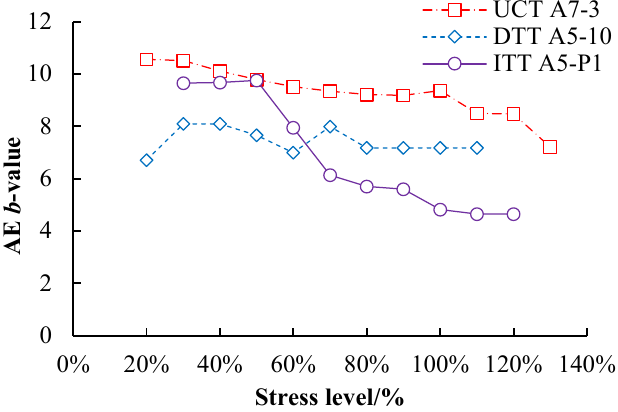
ff erent loading